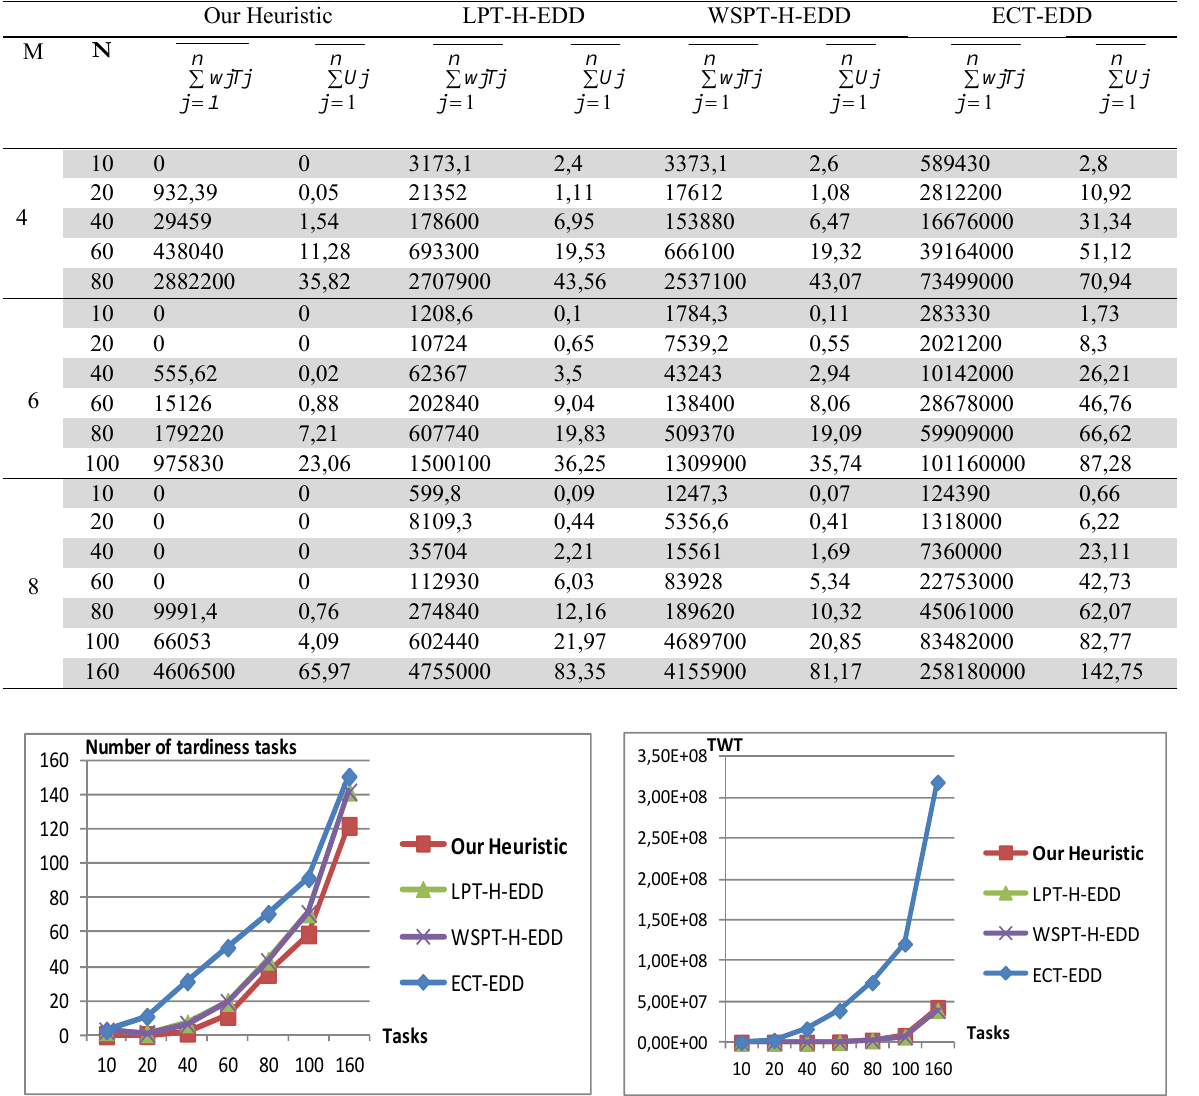
Fig. 5. Evolution of the both objective functions (TWT and number of late tasks) on 4